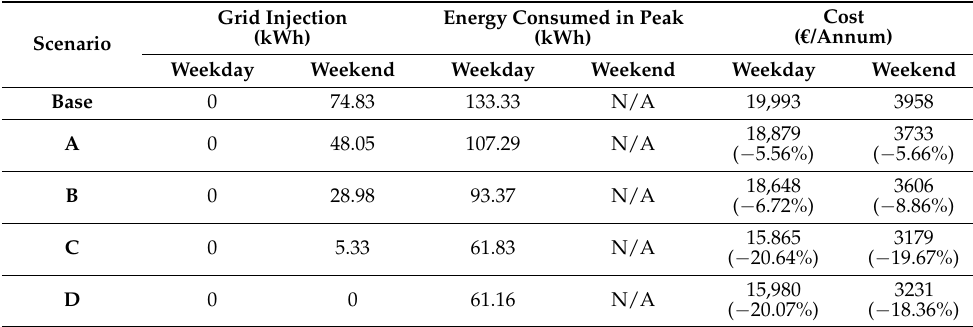
Table 8. Results for the economic